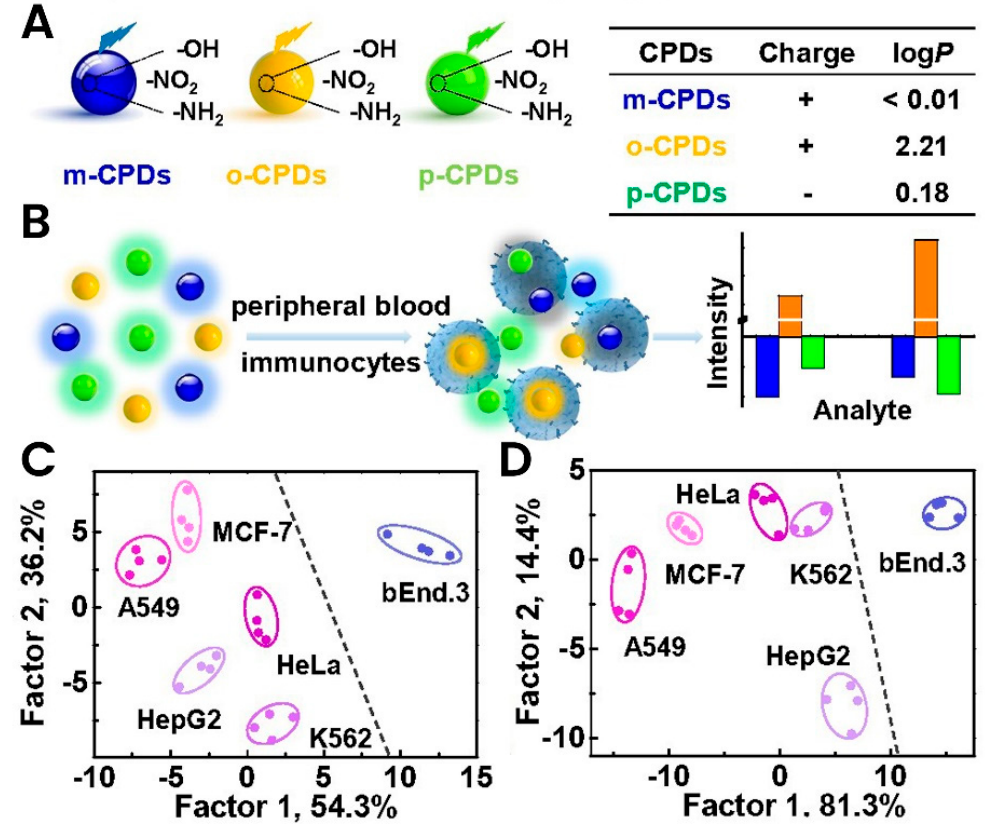
Figure 5. Carbon-based polymer dot (CPD) sensor for cancer diagnosis in the blood showing. ( A ) Schematic demonstration of three CPD forms and their characteristics. ( B ) Demonstration of the luminescence features changes during interaction with target blood cells. ( C , D ) Testing of the developed CPDs with various cancer cell lines showing the specific interaction and differentiation of each line. Reused with permission from Ref. [2] . ©2020 Royal Society of Chemistry.